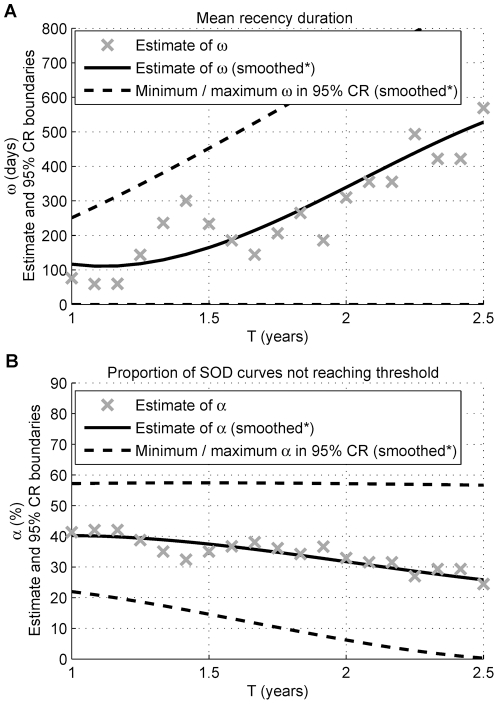
Estimated RITA characteristics for the Vitros-LS in the South African repeat donor population.The estimates of the RITA characteristics, ω and α, under the simultaneous estimation of the parameters are provided, as a function of the cutoff time T, for T = 1 year to T = 2.5 years. In Part A and Part B, estimates of ω and α are plotted, respectively. The minimum and maximum ω and α occurring in the 95% confidence regions (CRs) for these parameters are also displayed. *A polynomial is fitted by least squares to smooth estimates.